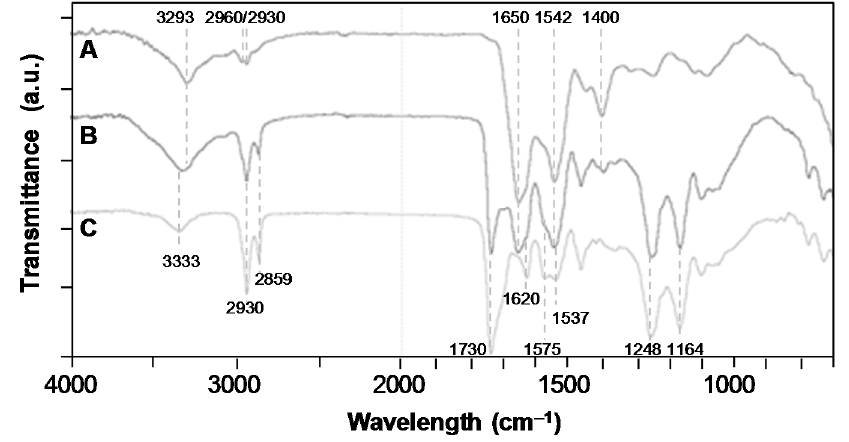
Figure 7. FTIR-ATR spectra of: A/Pure PRP (dry); B/PRP-PEUUF scaffold (dry); C/PEUUF scaffold (the LMW fucoidan concentration in the aqueous phase of the HIPE used for functionalization = 10 mg mL − 1 ; and the PRP concentration used for bio-activation = 15 vol% (16 h of incubation)).